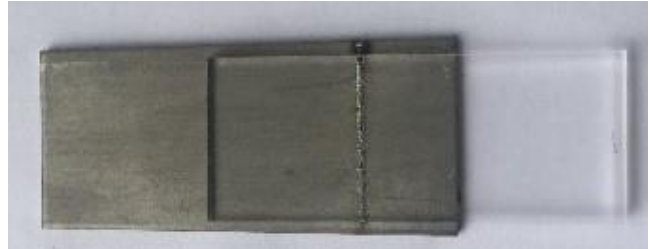
Figure 4. Welding between titanium alloy and high borosilicate glass.